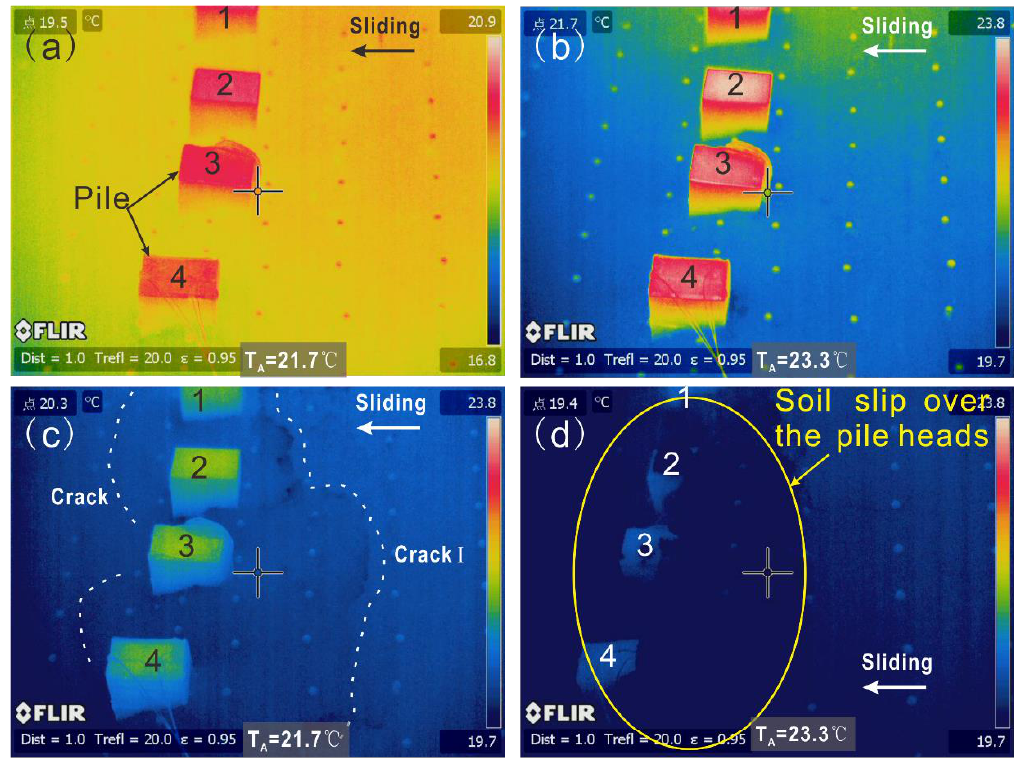
Figure 3. TIR of the model and landslide ( a ) 0.0 h, ( b ) 6.5 h, ( c ) 10.5 h, ( d ) 12 h. 𝑇 𝐴 is ambient temperature.